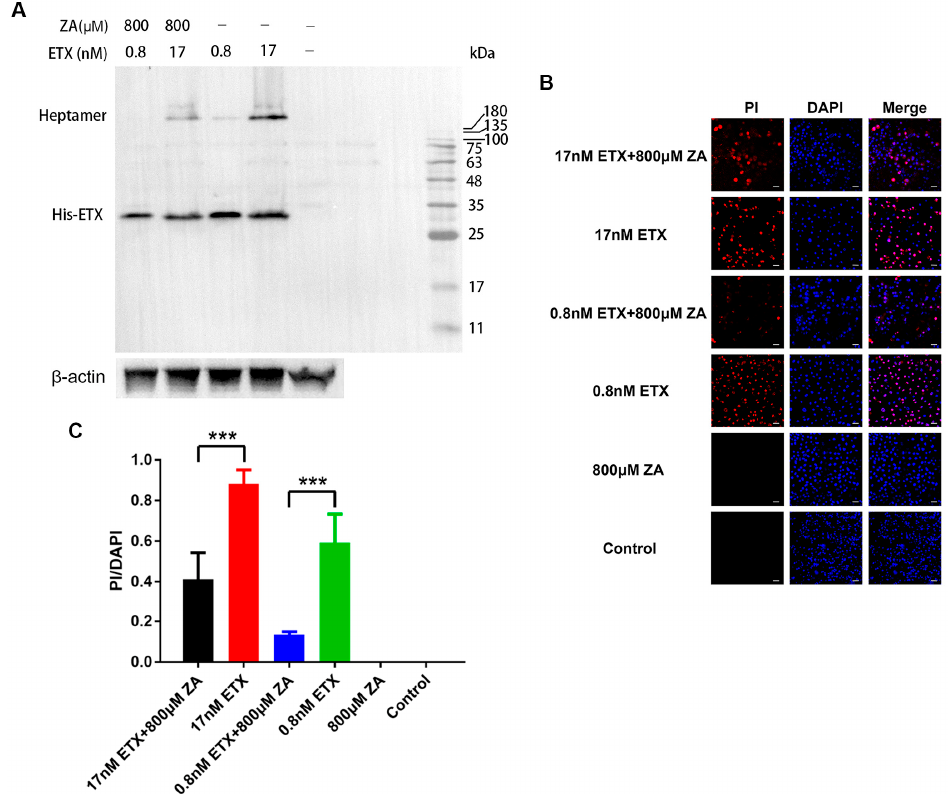
Figure 3. ZA reduces the formation of ETX heptamers and inhibits ETX-induced pore-formation in MDCK cells. ( A ) MDCK cells were incubated with ZA for 30 min and then treated with His-ETX for 1 h. Western blot analysis of cell lysates using anti-His revealed oligomeric complexes (~224 kDa) and monomeric forms of His-ETX (~32 kDa). Untreated MDCK cells were used as a control. ( B ) MDCK cells were cultured and incubated with 800 µM ZA for 30 min. Then, the medium was mixed with GST-ETX and propidium iodide staining (PI), followed by incubation for 1 h. After washing three times with PBS, the samples were stained with DAPI and observed using confocal microscopy. Scale bar: 50 µm. ( C ) The percent of PI-positive cells (PI/DAPI) with cells in different groups. *** p < 0.001.